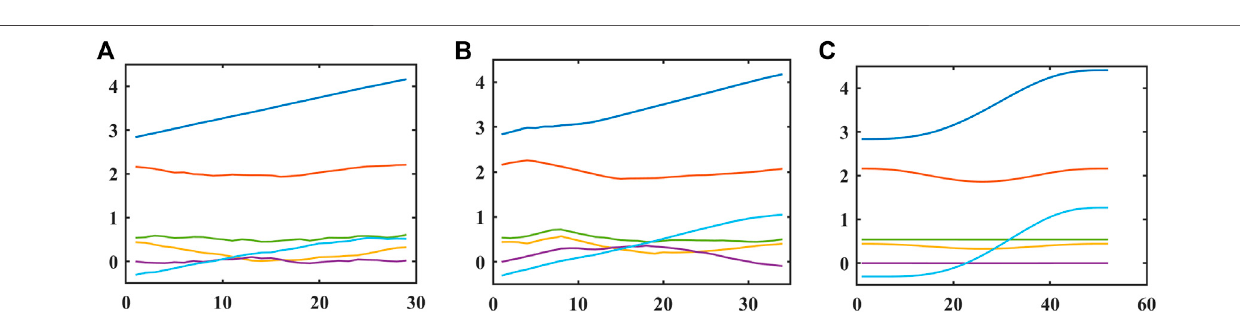
FIGURE 9 | Change curve of the angle of each joint of the manipulator. (A) D-SAC. (B) P-SAC. (C) PSO.